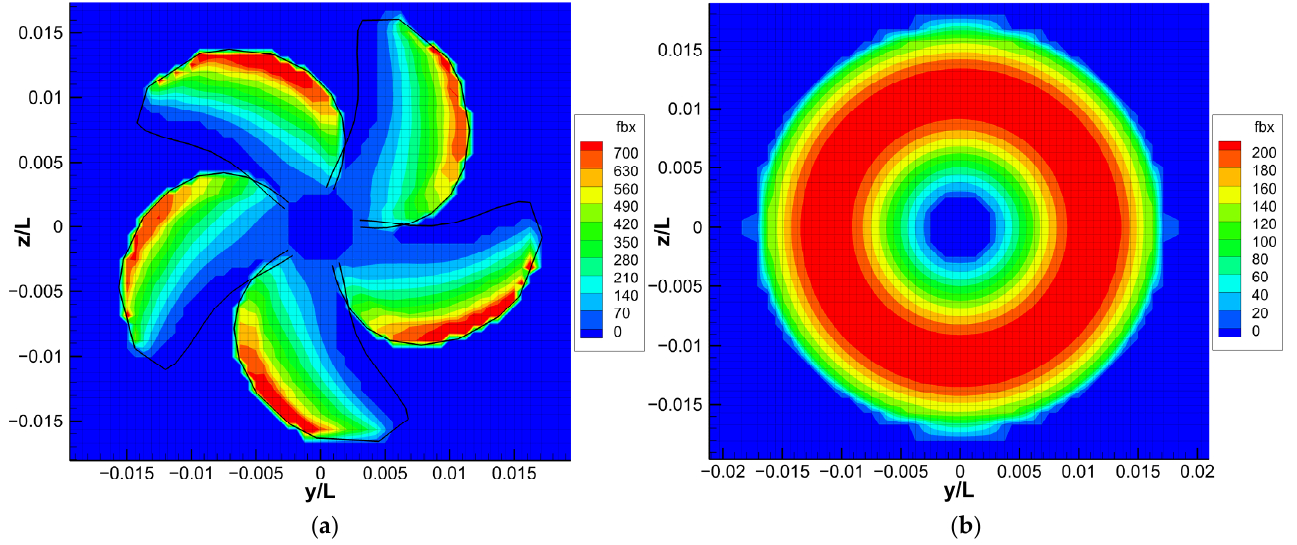
Figure 9. Body force distribution on the propeller plane ( J = 0.8): ( a ) rotating blade model; ( b ) average model.